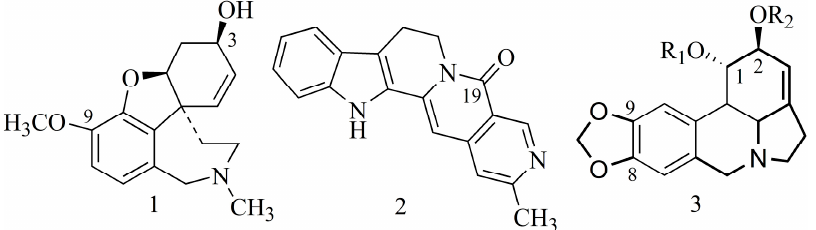
Figure 1. Chemical structures of galanthamine ( 1 ) and angustidine ( 2 ) and general structure of lycorine-type alkaloids ( 3 ).